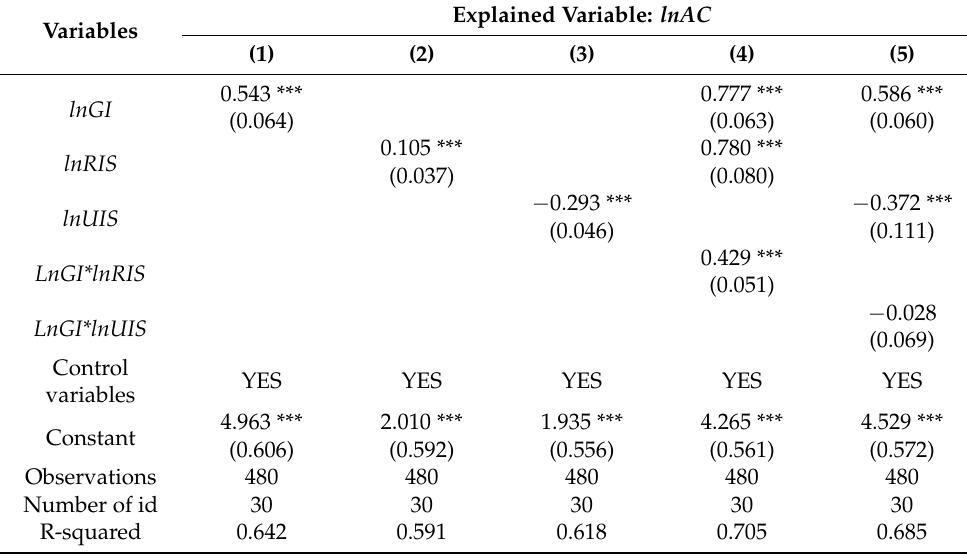
Table 6. Regression results for robustness with a reduced time scale.